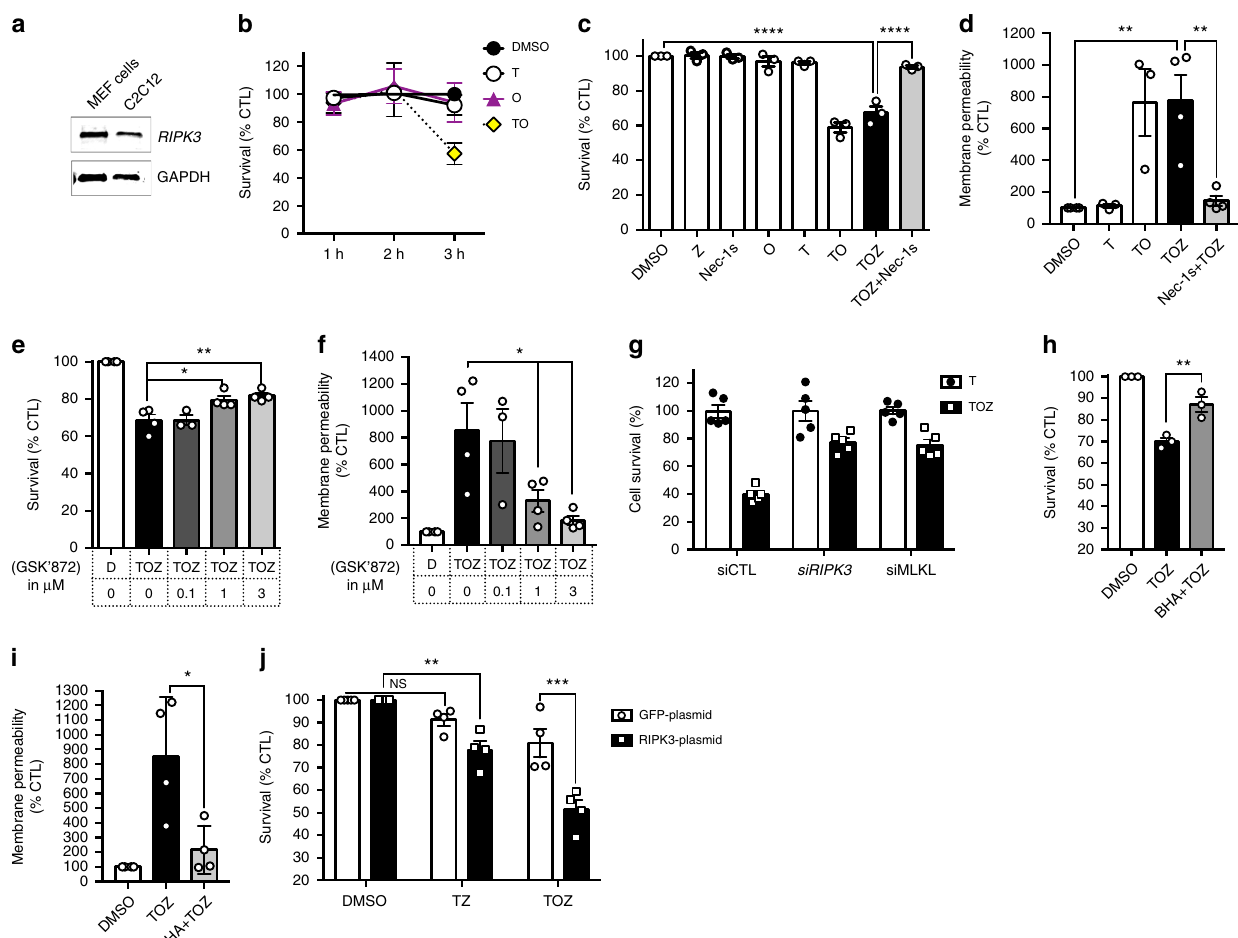
Fig. 2 RIPK3 upregulation facilitates TNF α -induced necroptosis in C2C12 myoblasts. a Immunoblot of RIPK3 expression in mouse embryonic fi broblast (MEF) cells and C2C12 myoblasts. b C2C12 myoblasts were exposed for 1, 2, or 3 h to either DMSO, mouse TNF α (100 ng/ml), TAK1 inhibitor (5Z)-7- Oxozeaenol (1 µ M), and TNF α + TAK1 inhibitor (respectively T, O, and TO treatment) and cell survival was assessed by measuring ATP levels (CellTiter-Glo assay). Levels of ATP in DMSO-treated cells were de fi ned as 100% survival. Data represented as the mean ± SEM of two independent experiments. c C2C12 myoblasts were challenged for 3 h with TNF α , (5Z)-7-Oxozeaenol, the pan-caspase inhibitor Z-VAD.fmk at 50 µ M (Z), and the inhibitor of RIPK1 kinase activity Necrostatin-1s (Nec-1s) at 30 µ M. Cell survival was assessed. Data presented as the mean ± SEM of three pooled independent experiments ( n = 3, one-way ANOVA). d Same experimental conditions as in ( c ). Membrane permeability of treated cells was assessed using CytoTox-Glo assay after 3 h of treatment. Data represented as the mean ± SEM of three pooled independent experiments ( n = 3, one-way ANOVA). e Cells were treated with TOZ for 3 h, with GSK ’ 872, a RIPK3 inhibitor. Cell survival was measured. Data presented as the mean ± SEM of four pooled independent experiments ( n = 4, one-way ANOVA). f Cells were treated as in e and membrane permeability was monitored by CytoTox-Glo assay. Data presented as the mean ± SEM of four pooled independent experiments ( n = 4, one-way ANOVA). g Ripk 3 or Mlkl mRNAs were knocked down using speci fi c RNAi. Transfected C2C12 cells were treated with either TNF α alone or TOZ and cell survival was assessed. Representative of two independent experiments ( fi ve replicates per group). h – i C2C12 myoblasts were challenged by TOZ with or without Butylated hydroxyanisole (BHA). Cell survival ( h ) and membrane permeability ( i ) were monitored. Data presented as the mean ± SEM of four pooled independent experiments ( n = 4, one-way ANOVA). j C2C12 myoblasts were transfected with a GFP plasmid or a GFP -tagged Ripk3 plasmid. Transfected cells were stimulated and the survival was monitored ( n = 4 pooled independent experiments, two-way ANOVA). Data shown as the mean ± SEM. * P < 0.05, ** P < 0.01, *** P < 0.001, **** P < sorted and then stimulated with necrotic triggers. Cell death